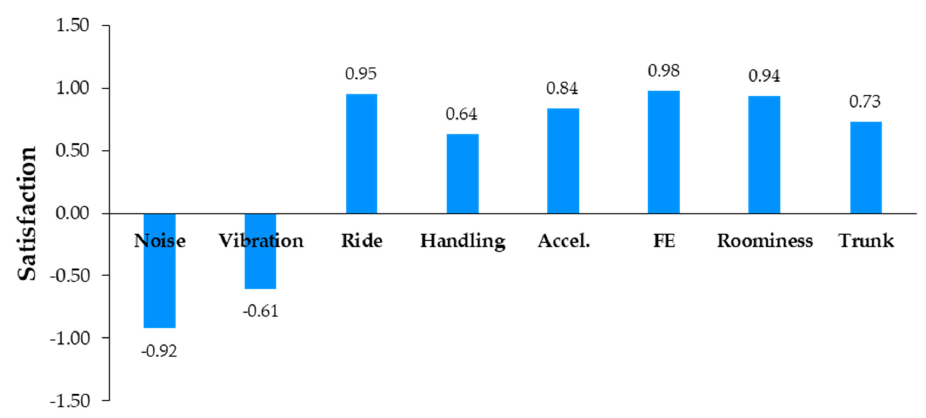
Figure 10. Amount of mentions for each performance aspect of “Product D”, released in the second half of 2019.